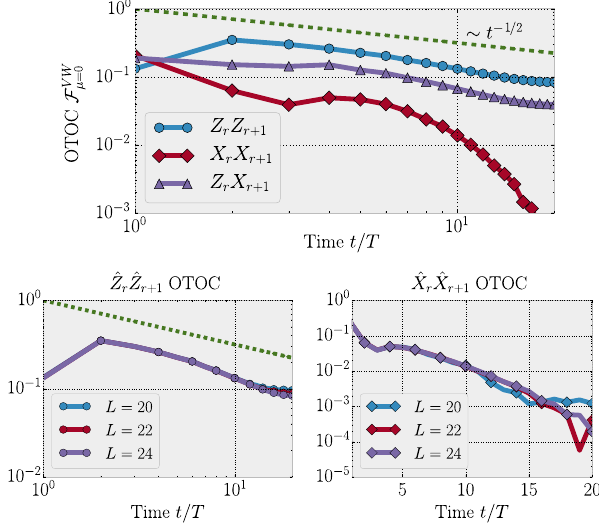
FIG. 6. OTOC for different operators on nearest-neighbor sites at zero chemical potential in the nonrandom Floquet model P ˆ Z Eq. (16) which conserves r . Upper panel: OTOCs on r nearest-neighbor sites for system size L ¼ 24 sites. Both the ˆ Z ˆ Z ˆ Z ˆ X and the OTOC decay as a power law, approximately as ∼ t = 1 = 2 , while the ˆ X ˆ X OTOC decays faster than a power law, as shown by the log-log plot in the upper panel. The lower two panels show a comparison between system sizes L ¼ 20 , 22, 24 ˆ Z ˆ Z ˆ X ˆ X for the and OTOCs, respectively. The latter is shown in a lin-log plot and is well approximated by an exponential